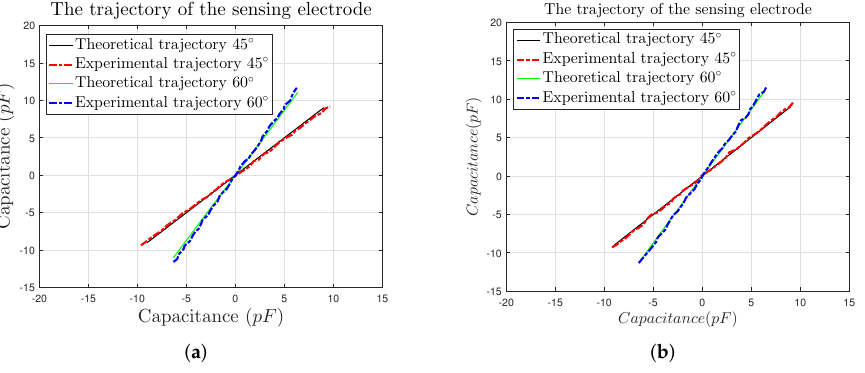
Figure 12. The trajectory of the sensing electrode: ( a ) the trajectories derived by uncompensated experimental values, ( b ) the trajectories derived by compensated experimental